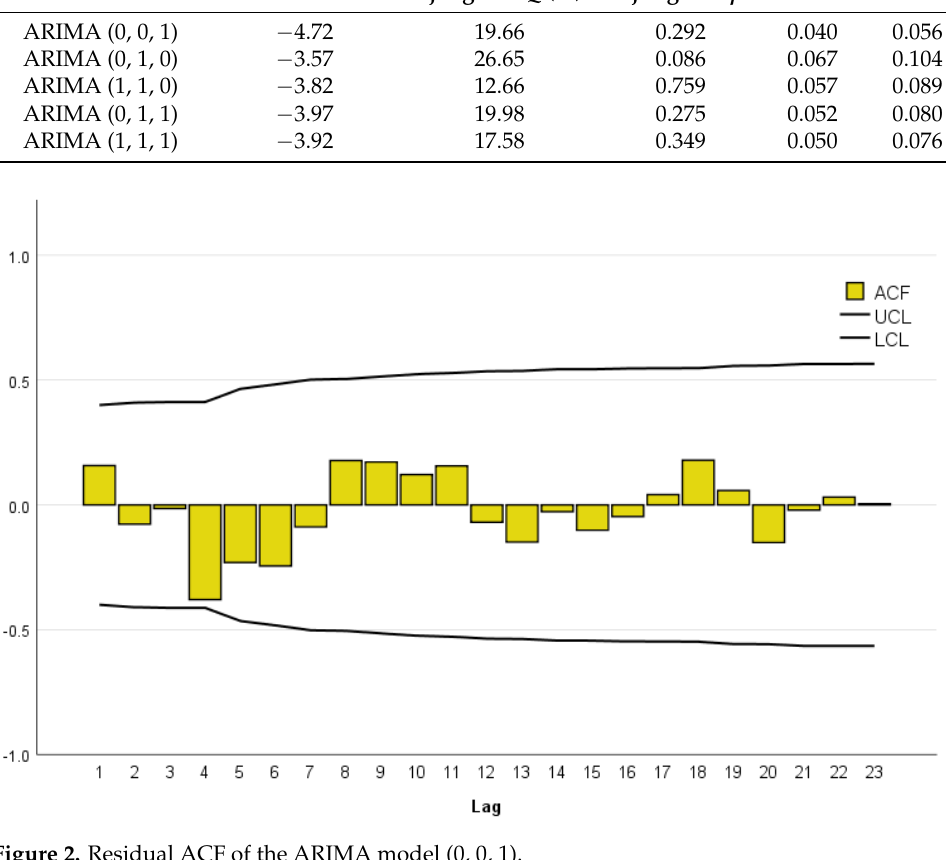
Table 1. Model Comparisons.